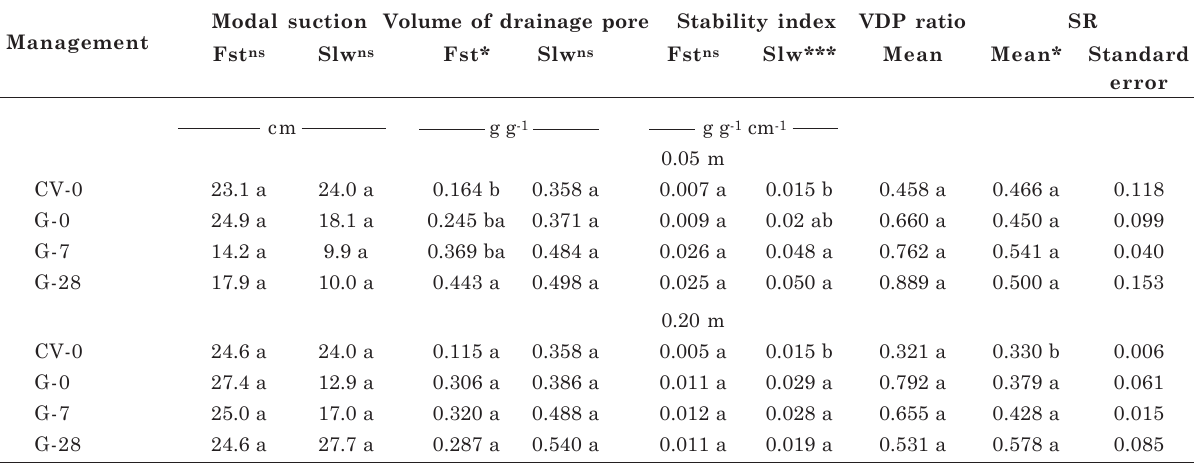
Fst: fast wetting; Slw: slow wetting; ns: not significant; *: significant p<0.05; ***: significant p<0.001. Means followed by the same letter in the column (within the same soil depth) did not differ according to Fisher’s Least Significant Difference (LSD) test